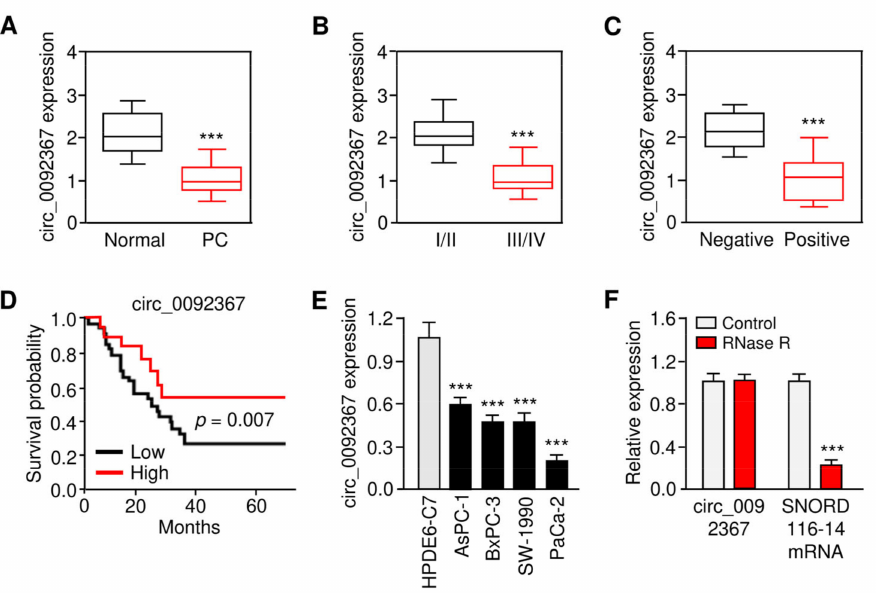
Figure 1. Circ_0092367 Expression Is Downregulated in PC. ( A ) qRT-PCR analysis of circ_0092367 expression in PC tissues compared with matched adjacent normal tissues. ( B ) The expression level of circ_0092367 in PC patients with different tumor stages. ( C ) The expression level of circ_0092367 in PC patients with or without lymph node metastasis. ( D ) Kaplan–Meier curves in PC patients with low versus high expression of circ_0092367. ( E ) qRT-PCR analysis of circ_0092367 expression in human PC cell lines and a normal pancreatic cell line HPDE6-C7. ( F ) Circ_0092367 and SNORD116-114 mRNA expressions were analyzed with qRT-PCR assays in PaCa-2 cells treated with (or without) RNase. The experiments in ( E ) and ( F ) were repeated three times independently with similar results. *** p